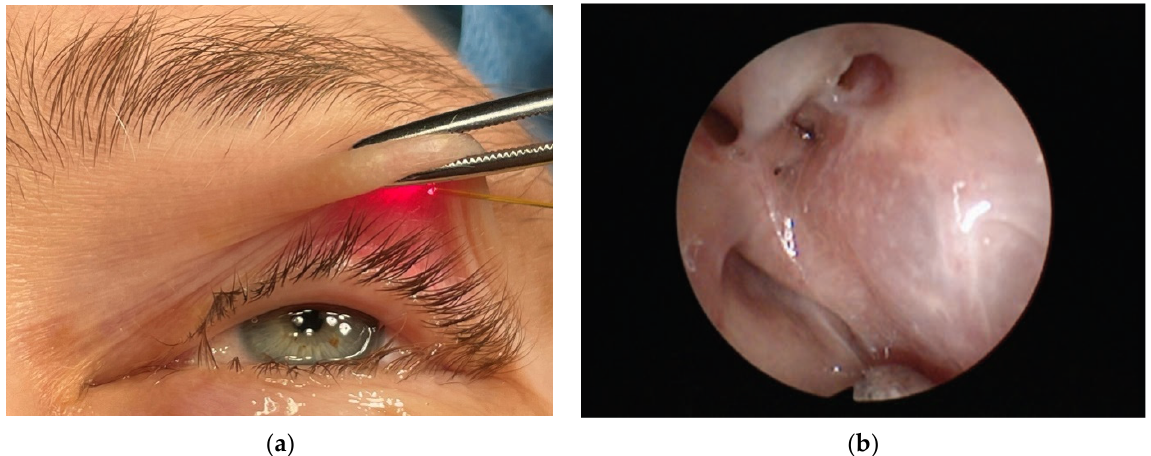
Figure 6. The laser-assisted ( a ) blepharoplasty and ( b ) nasolacrimal duct anastomosis 12 months after procedure.